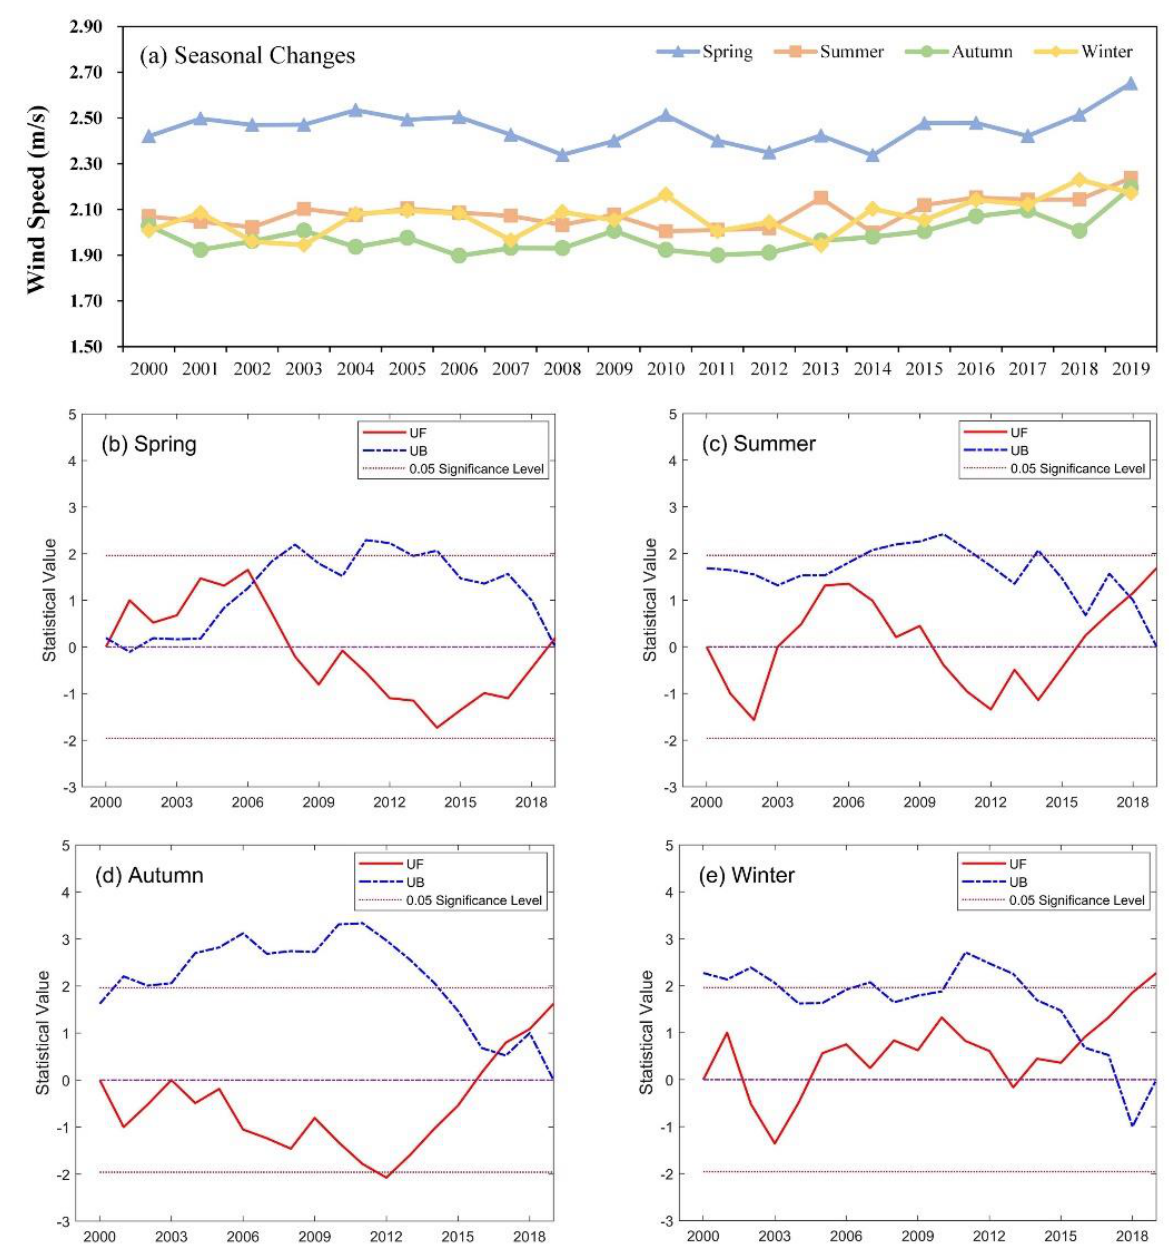
Figure 3. ( a ) Seasonal changes in wind speed from 2000 to 2019 in China. Statistical curve of the M–K trend and abrupt test for four seasons: wind speeds in ( b ) spring, ( c ) summer, ( d ) autumn, and ( e ) winter from 2000 to 2019 in China.